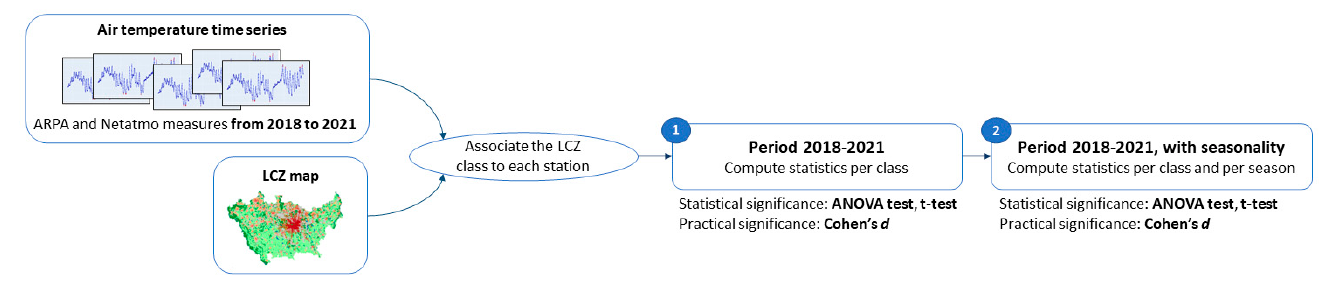
Figure 6. Flowchart followed for the analysis of the relation between LCZ and air temperature.